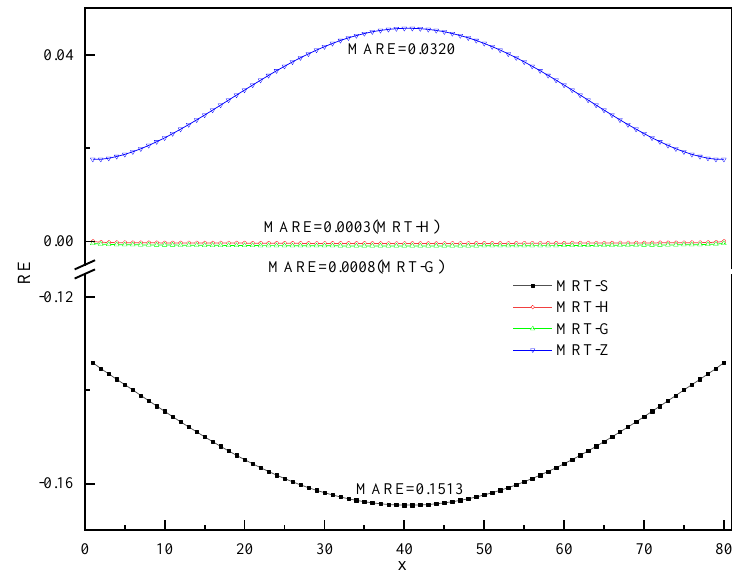
Figure 5. RE and MARE of x v along vertical centerline of ROI (x = 140.5)